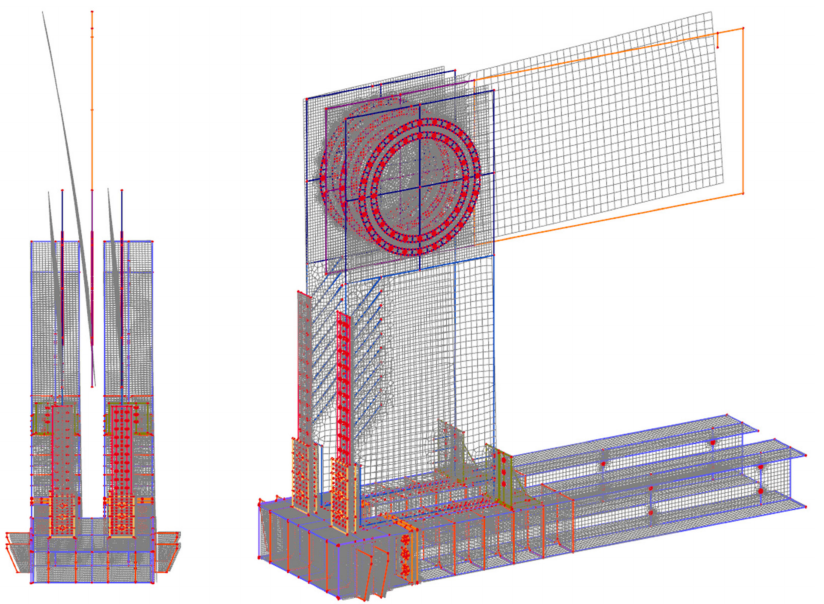
Figure 7. Computational model (global stability)—mesh finite